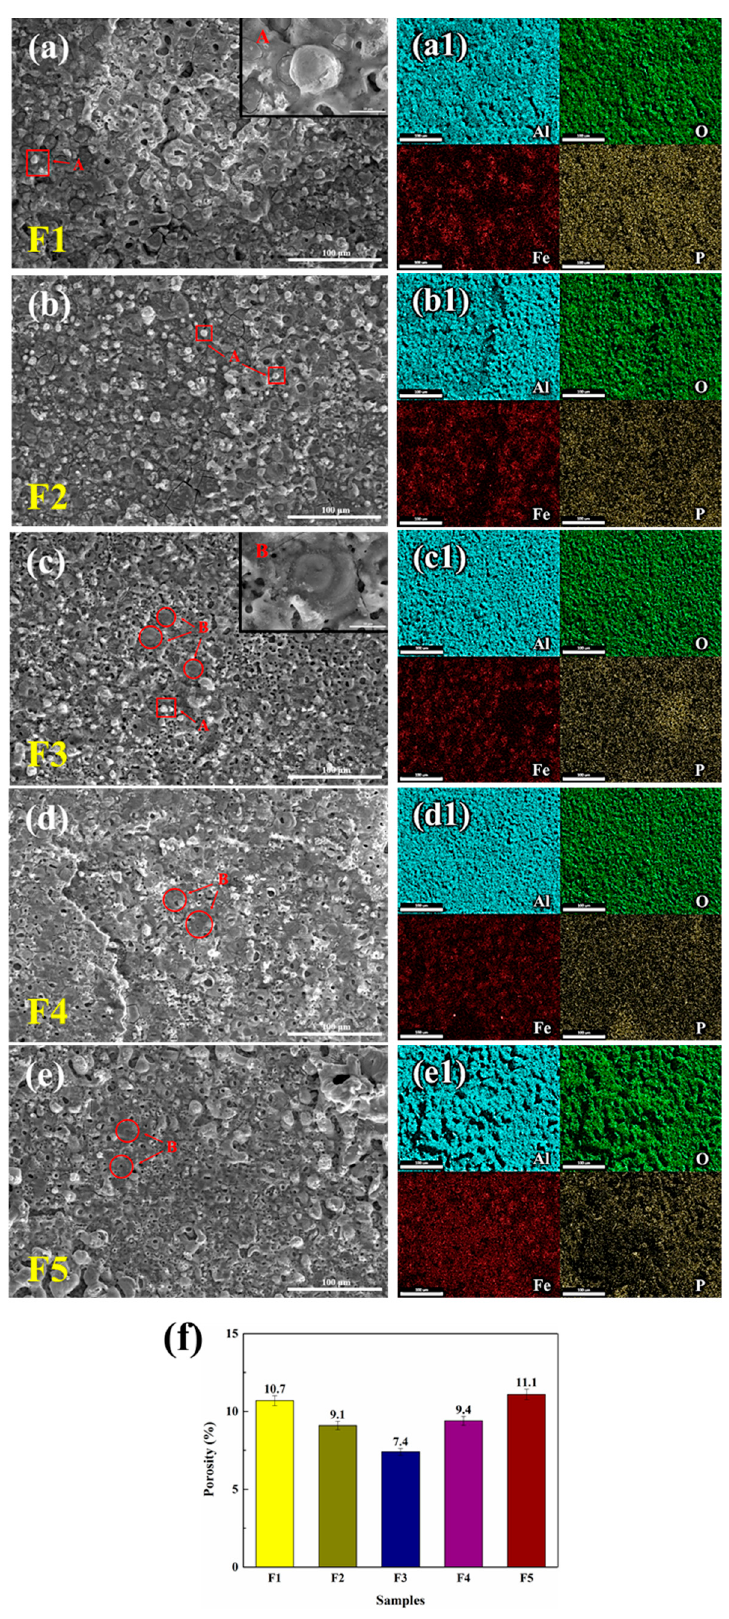
Figure 2. SEM images (1000×) of the coating surface and EDS analysis (2000×): ( a , a1 ) F1; ( b , b1 ) F2; ( c , c1 ) F3; ( d , d1 ) F4; ( e , e1 ) F5 and ( f ) surface porosity of MAO coatings under different negative voltages.